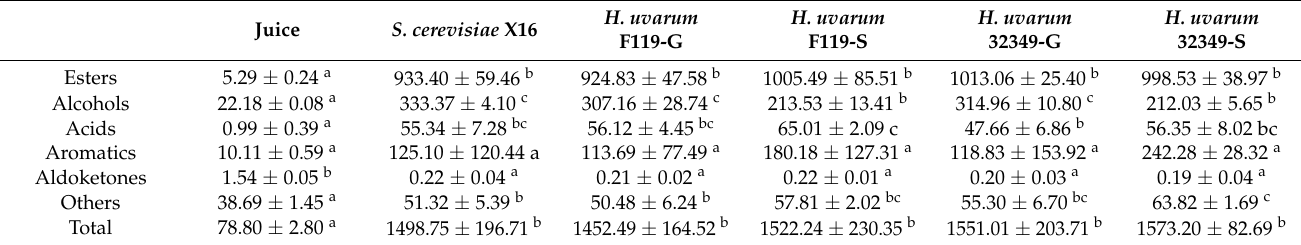
Table 3. Volatile aroma compound content (mg/L) in blueberry juice and blueberry fruit wines.